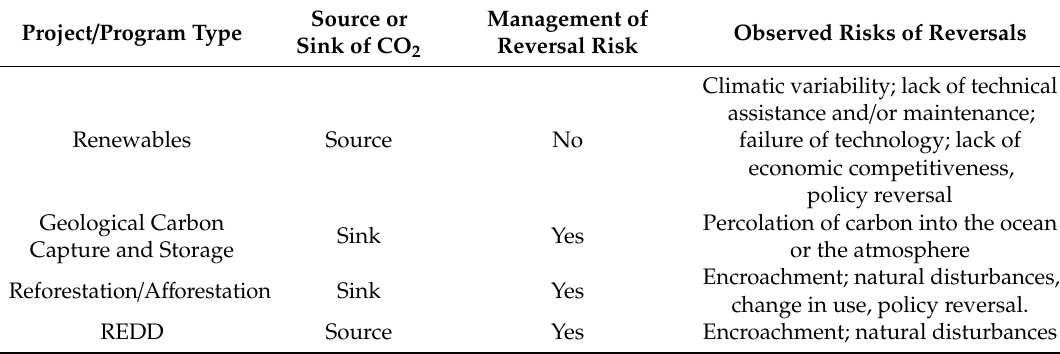
Table 1. Management of Reversals by Various Projects / Program